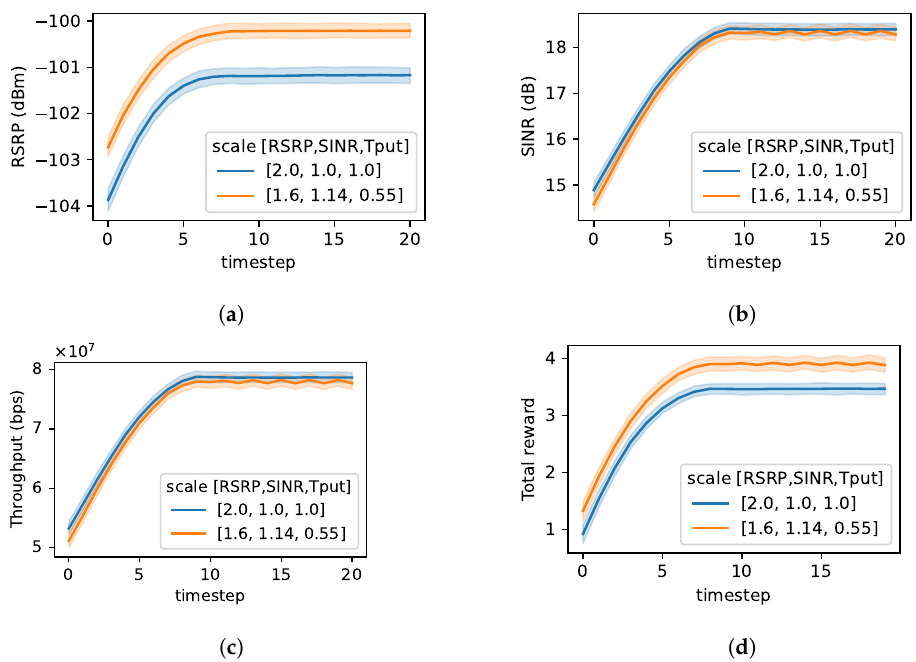
Figure 12. The average network metrics from fifty episodes showing the performance of the agent with original (blue) and adjusted reward weights (orange). ( a ) The RSRP signal on the evaluation phase. ( b ) The SINR signal on the evaluation phase. ( c ) The throughput signal on the evaluation phase. ( d ) The total reward on the evaluation phase.